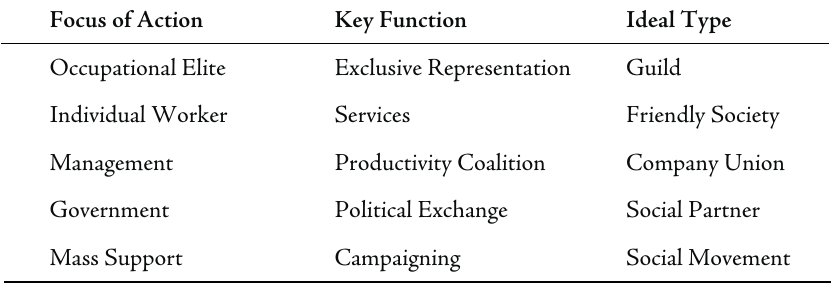
Table 1 – Five Alternative Trade Union Identities* Focus of